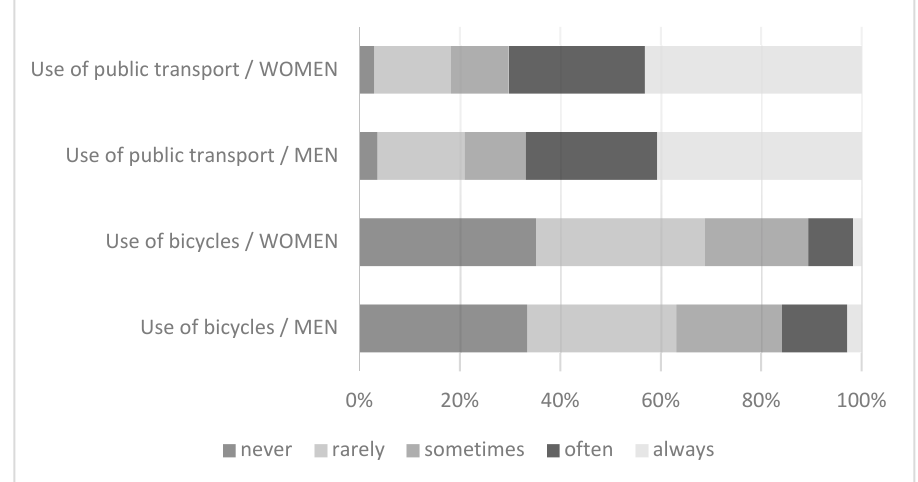
Figure 1. The frequency of public transport (PT) and bicycle use.